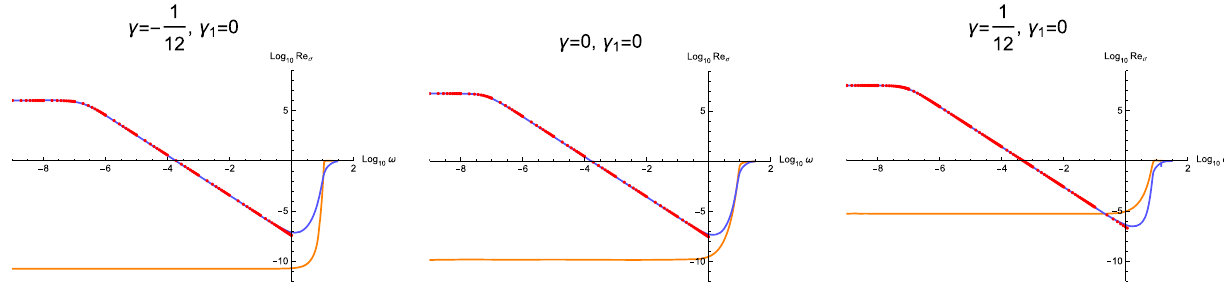
Fig. 6 Logarithmic real parts of conductivity versus the logarithmic frequencies in 4 derivative theory with different coupling parameter γ . The blue line is σ xx while the orange line for σ yy . The red points are the fitting of σ xx for various γ in the low frequency